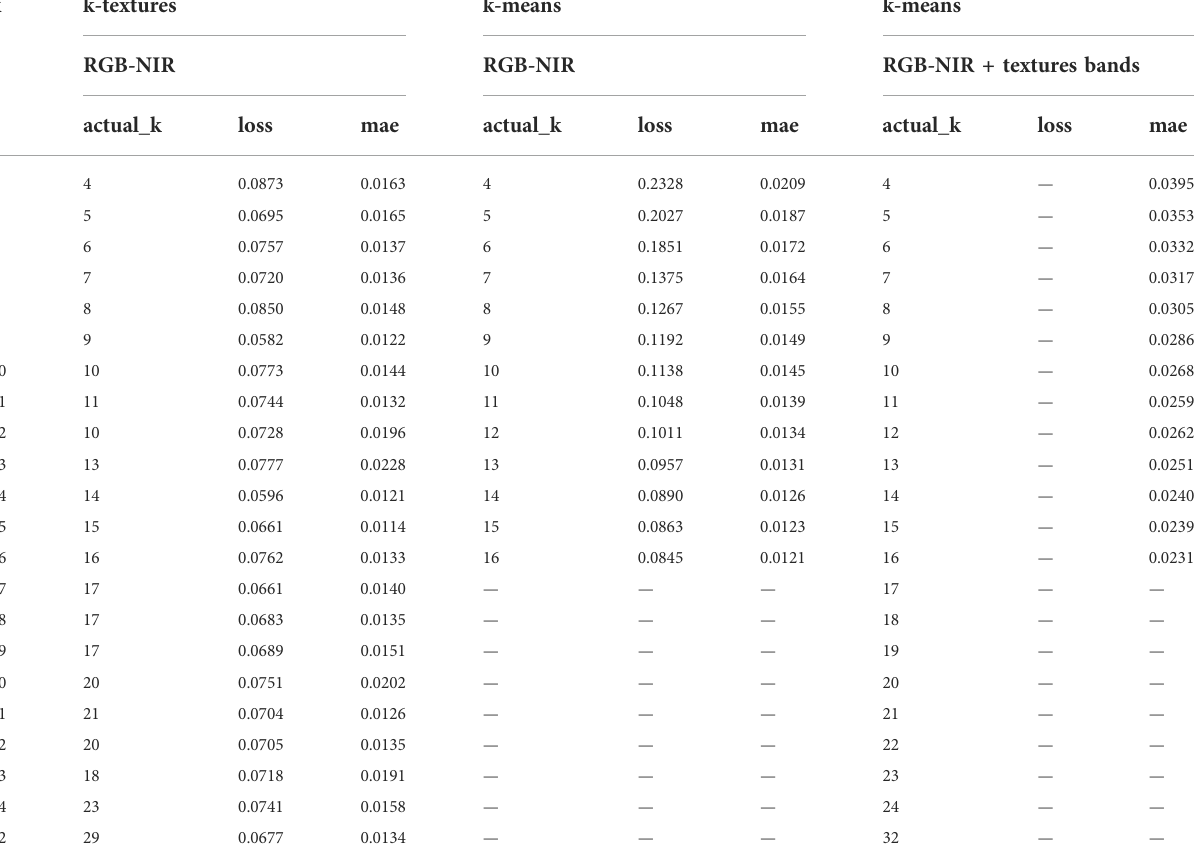
TABLE 1 Comparison between the k-textures and the k-means models of the number of clusters found (actual k), the feature loss and the mean absolute error (MAE). MAE was computed a posteriori between the original image and the image produced by k-means, that is, with the cluster centersusedastextureforeachclass.Thelossofk-meansforthe4-bandsdatasetwascomputedusingthelossfunctionofthek-texturesmodelwith the observed image and the image with cluster center values for each cluster.